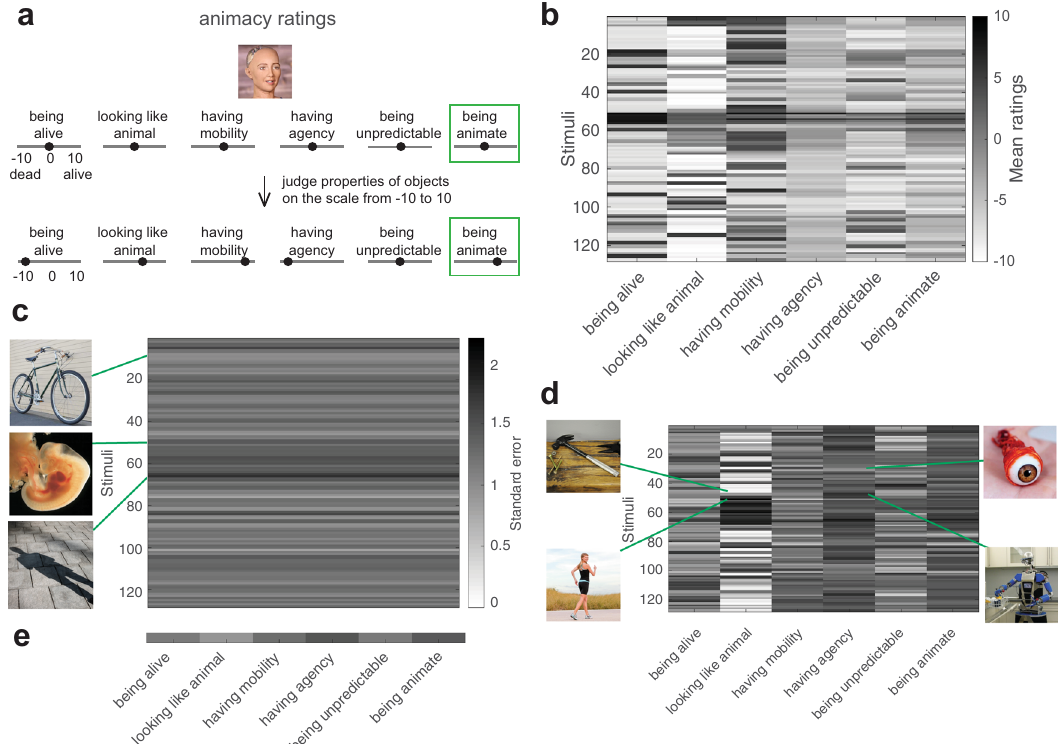
Fig. 3 Animacy ratings and their consistency with examples of images judged consistently and not very consistently. a Illustration of animacy ratings. Participants judged each object image using a continuous scale from − 10 to + 10 for each animacy dimension, e.g., − 10 meant “ dead ” and + 10 meant “ alive ” for the “ being alive ” dimension. Additionally, participants performed a rating of “ being animate ” dimension in a similar fashion. b Mean ratings of each animacy dimension andstimulus across 19participants. c Consistency of each stimulusin animacy ratingsacross participants(standard error of the mean)with examples of stimuli with varying values of standard error. d Consistency of each animacy dimension and stimulus in animacy ratings across participants with examples of stimuli with varying values of standard error for the most consistently judged ( “ looking like an animal ” ) and the least consistently judged ( “ having agency ” ) dimensions. e Consistency of each animacy dimension in animacy ratings across participants (standard error of the